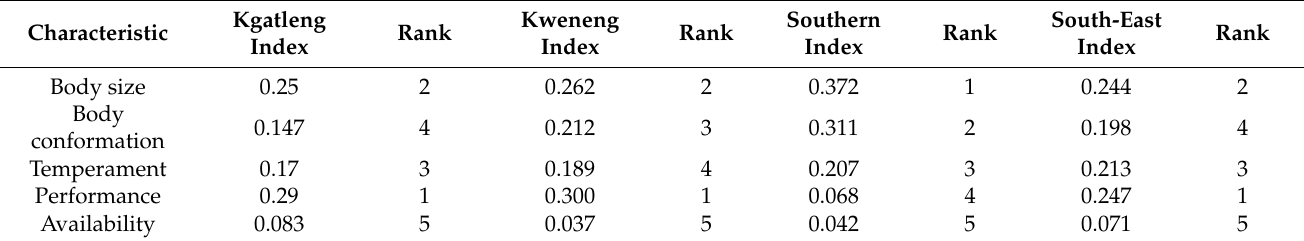
Table 5. Ranking of selection criteria of rams in the four surveyed Districts of Botswana.